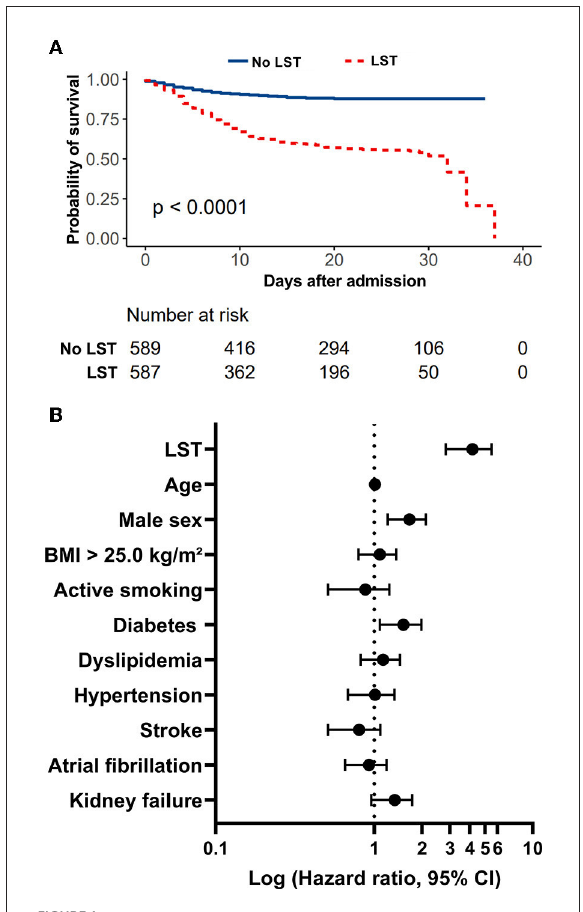
FIGURE1 Evaluation of LST decision on in-hospital mortality in a retrospective study of COVID-19 patients admitted to medical wards during the first wave. (A) In-hospital mortality rate of patients with COVID-19 admitted to medical wards treated with or without LST decision. (B) LST is a strong predictor of in-hospital mortality in COVID-19 patients admitted to medical wards during the first wave. Forest plot summarizing results of Cox proportional-hazard model for in-hospital mortality adjusted on all